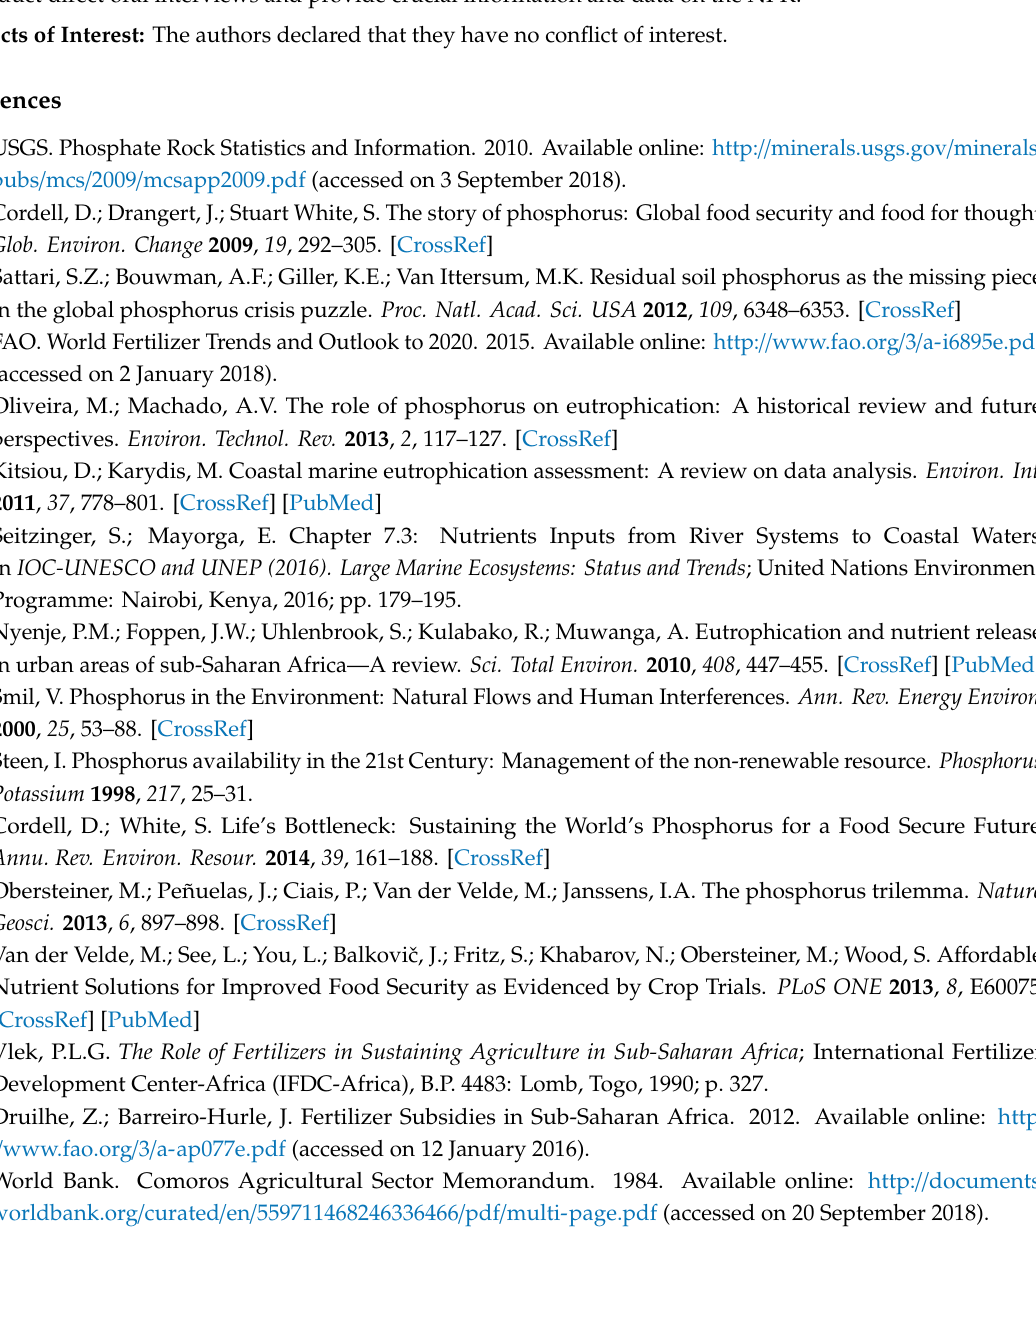
Table S2: Data, sources, and equations for 2000, Table S3: Comparison of the characteristics of P flow between Australia, China, and Comoros, Table S4: Comparison of total P input per capita on the agricultural land, for di ff erent